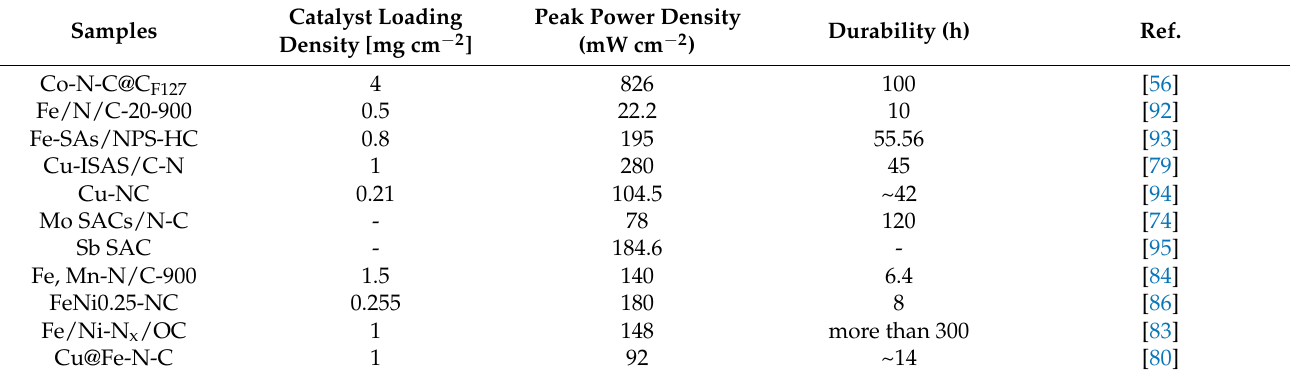
Table 2. The performance of Zn-air batteries with recently reported M SAC -N-C catalysts derived from